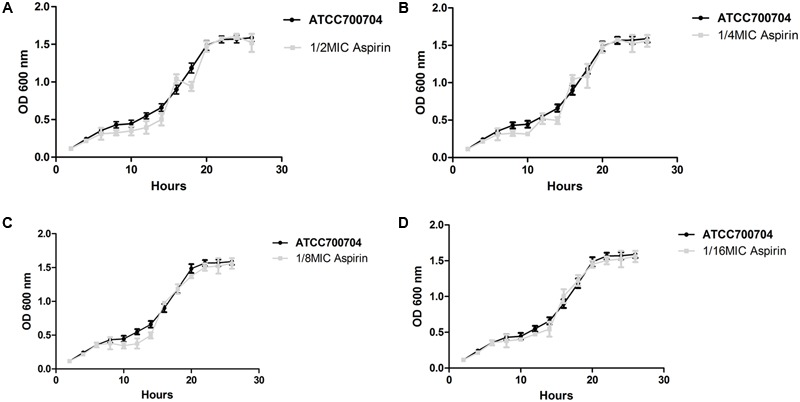
Growth curve of S. xylosus ATCC700404 in the absence of aspirin and in the presence of aspirin at doses of, 1/2 (A), 1/4 (B), 1/8 (C), or 1/16 MIC (D). Data are expressed as the mean ± standard deviation.